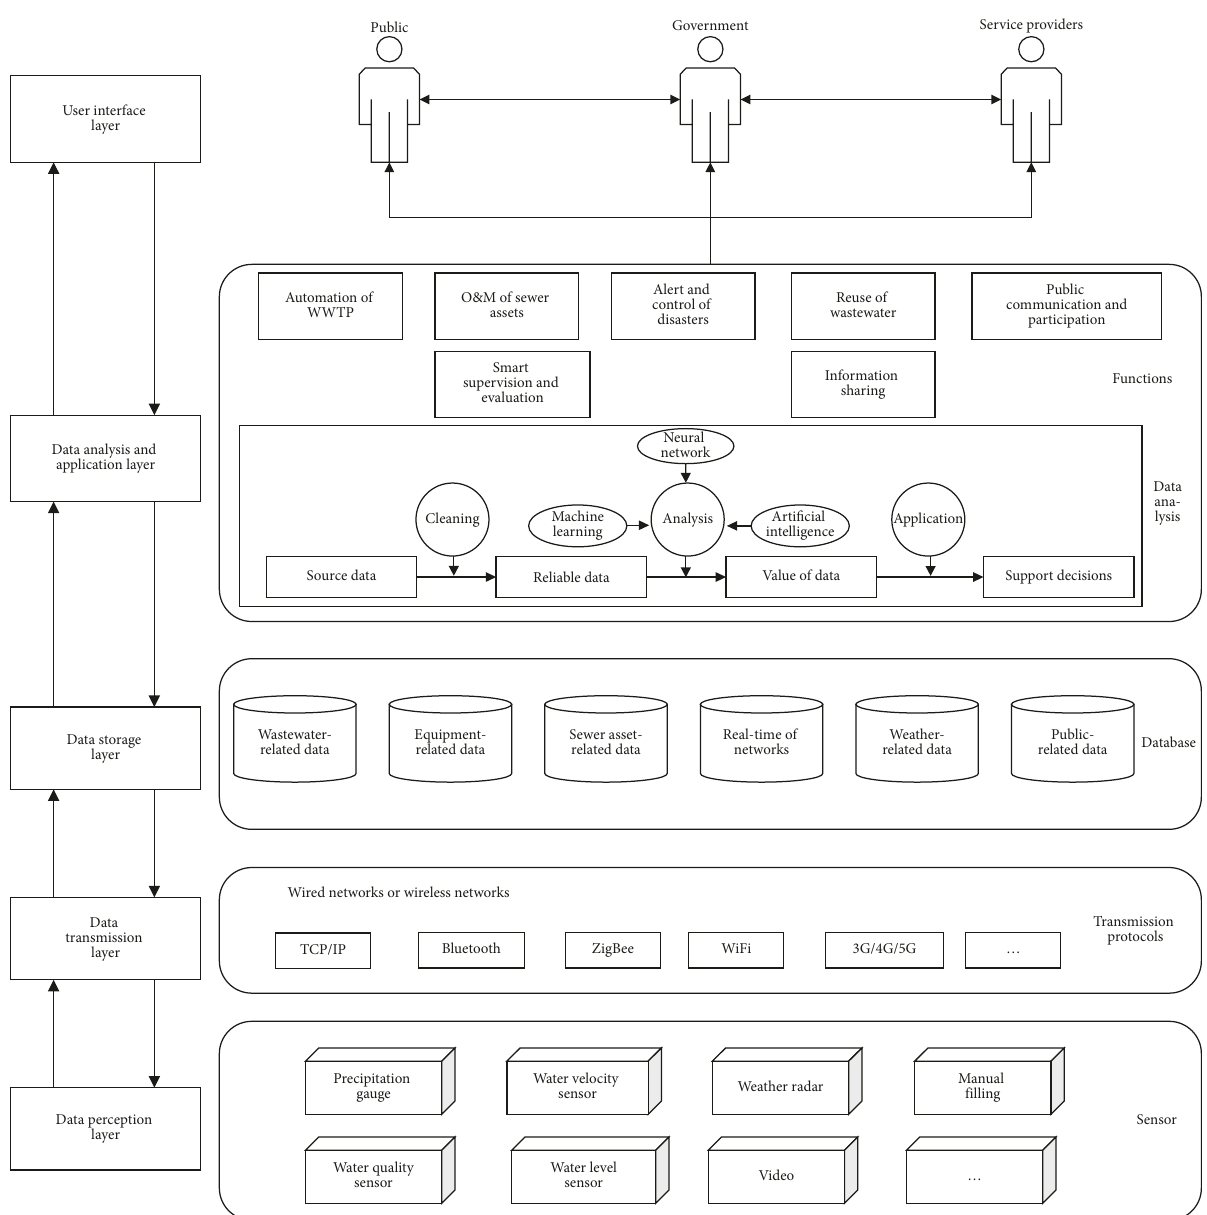
Figure 7: The data-driven framework of